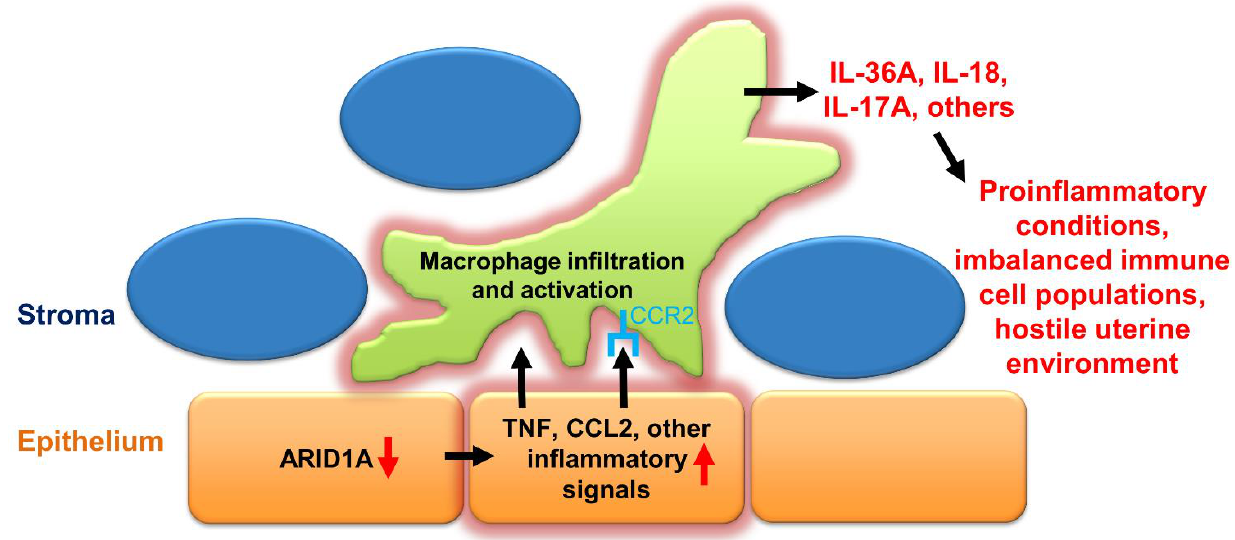
Figure 7. Proposed mechanism: Endometrial epithelial ARID1A loss leads to increased proinflam- matory cytokine expression and macrophage-driven uterine inflammation during early pregnancy.